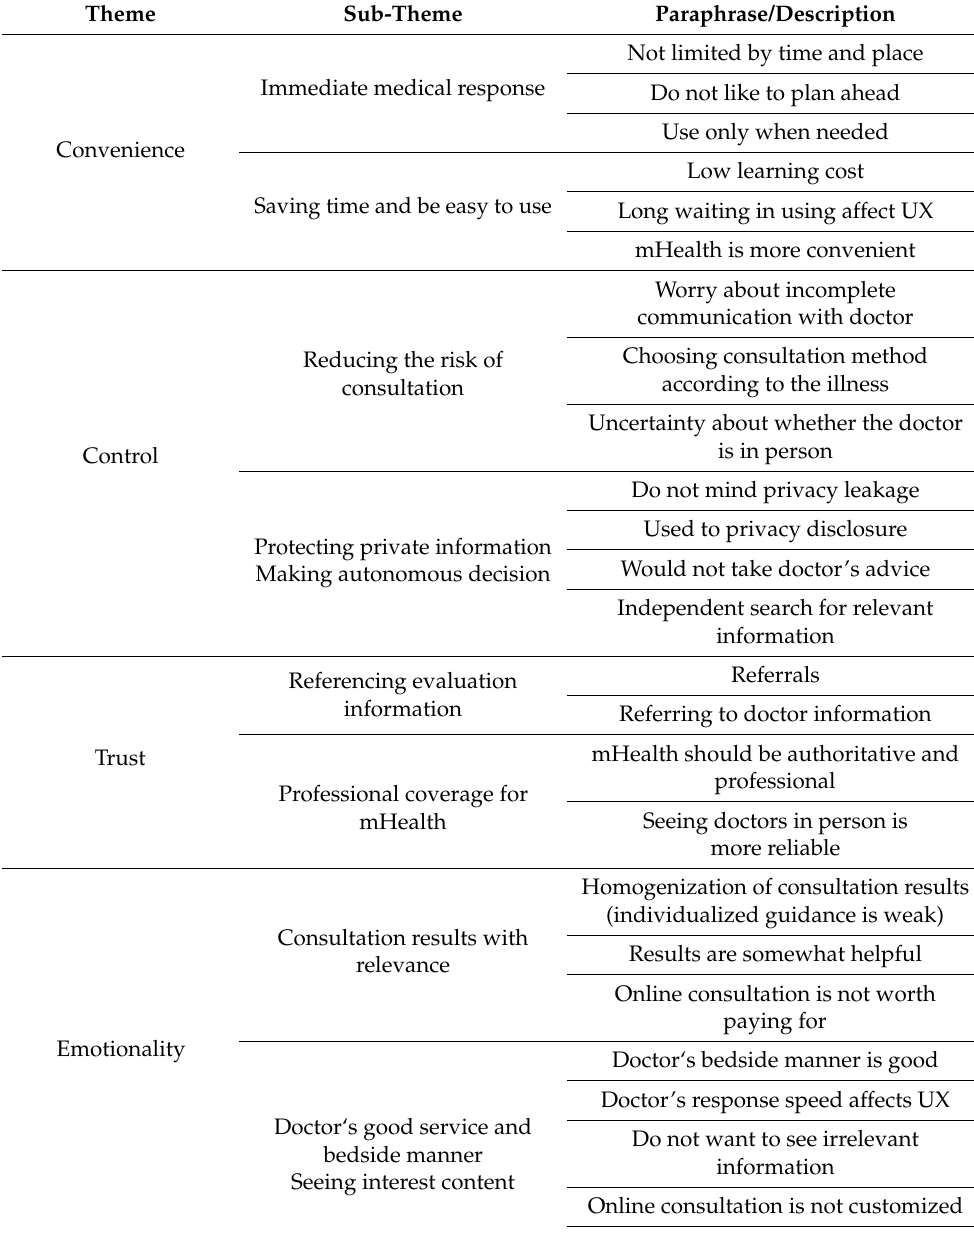
Table 5. The three-level